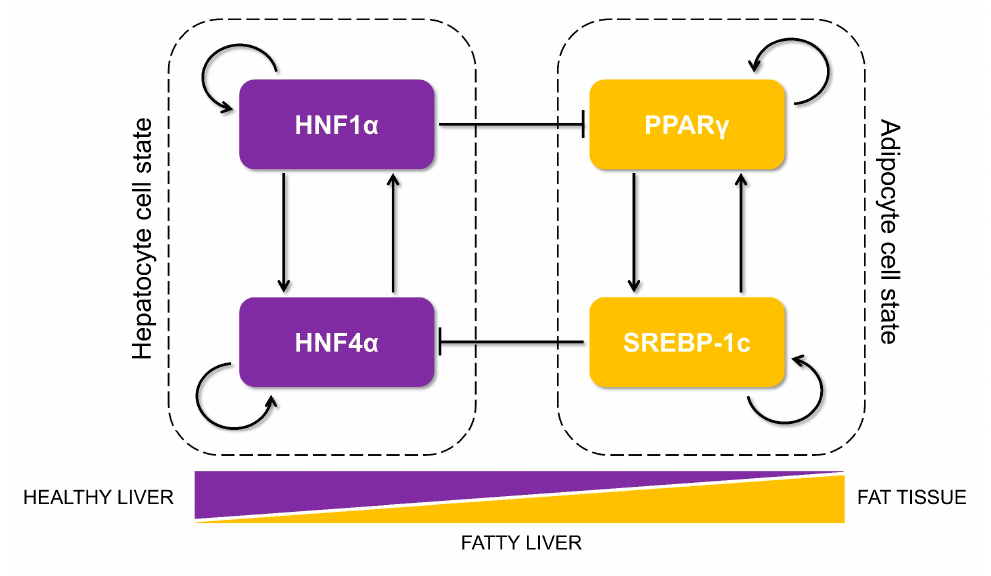
Figure 1. Proposed core regulatory network motif that controls lipid homeostasis in the liver and is dysregulated during the progression of non-alcoholic fatty liver disease (NAFLD). The motif is composed of two tightly regulated, self-activated pairs of transcription factors (each pair shown in a dotted rectangle): HNF4 α / HNF1 α (maintaining the hepatocyte cell state) and PPAR γ / SREBP-1c (driving an adipocytic cell state and implicated in initiation and progression of NAFLD). The arrows show transcriptional activation, and the solid bars represent transcriptional repression. The relative levels of these proteins in a cell can determine its cell state as hepatocytes in healthy liver, adipocytes in the fat tissue, or steatotic hepatocytes in livers of patients suffering from fatty liver.